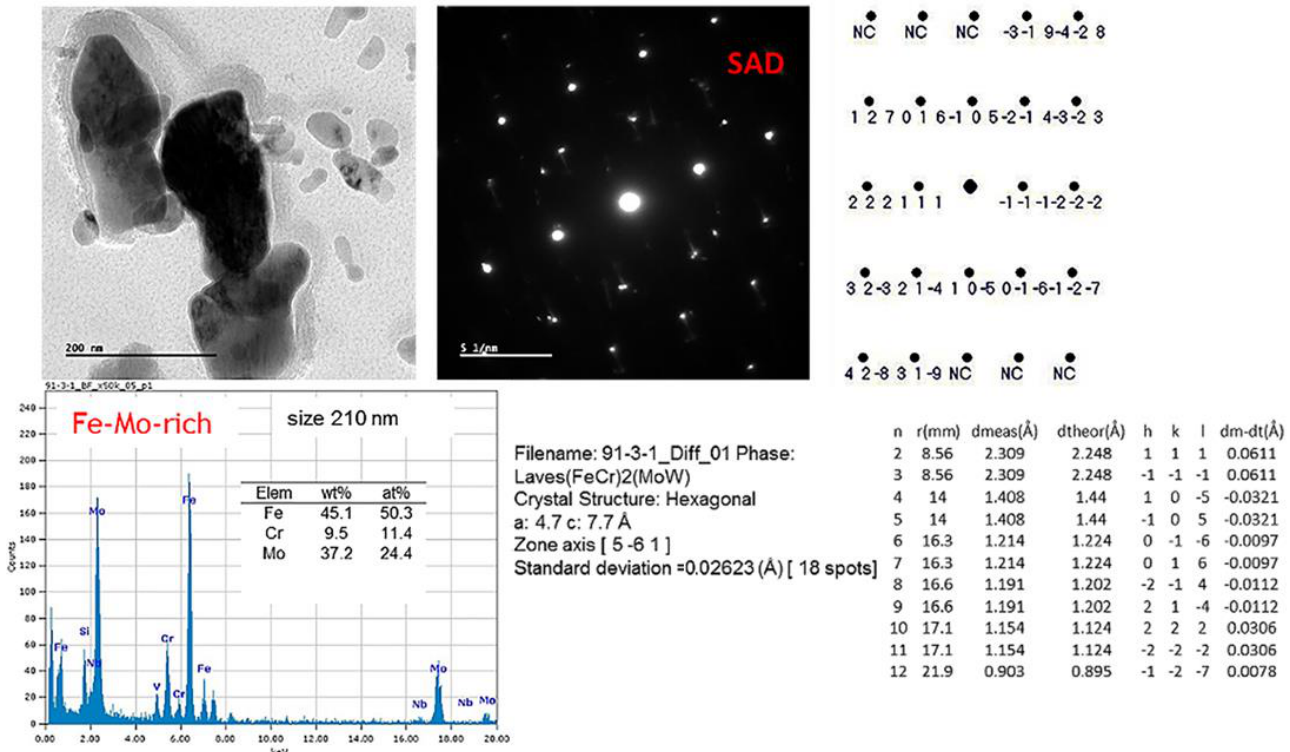
Figure 9. Failed crept cross-weld specimen 91-HAZ-3-1 550 ◦ C 200 MPa 4395 h. TEM SAD (Selected Area Diffraction) and EDS (Energy Dispersive Spectroscopy) microanalysis on Fe2Mo (Laves phase).